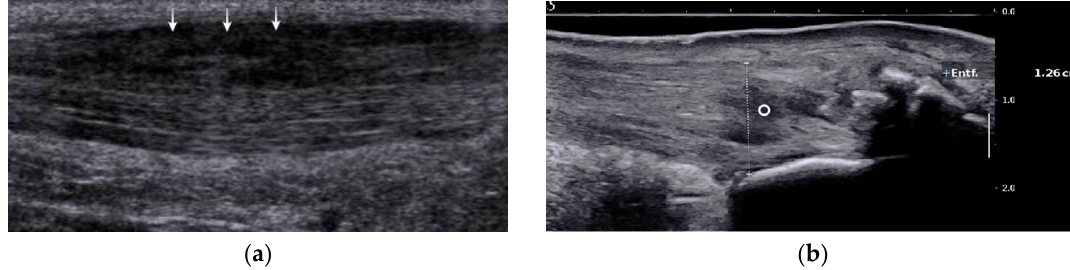
Figure 2. US images of partial Achilles tendon ruptures: ( a ) partial rupture in the dorsal part of the Achilles tendon midportion (arrows); ( b ) partial rupture in insertional area of the Achilles tendon (circle). US; ultrasound.